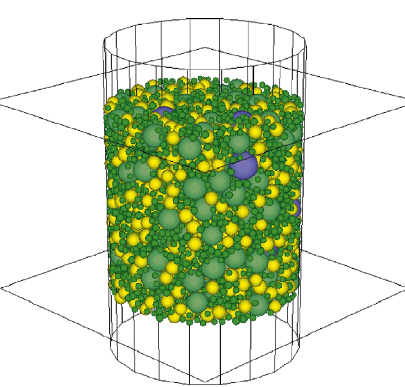
Figure 4: Arrangement of aggregate particle.